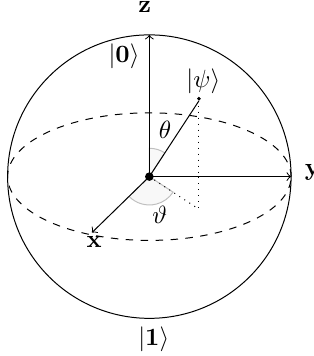
Figure 2 . Qubit representation by the Bloch